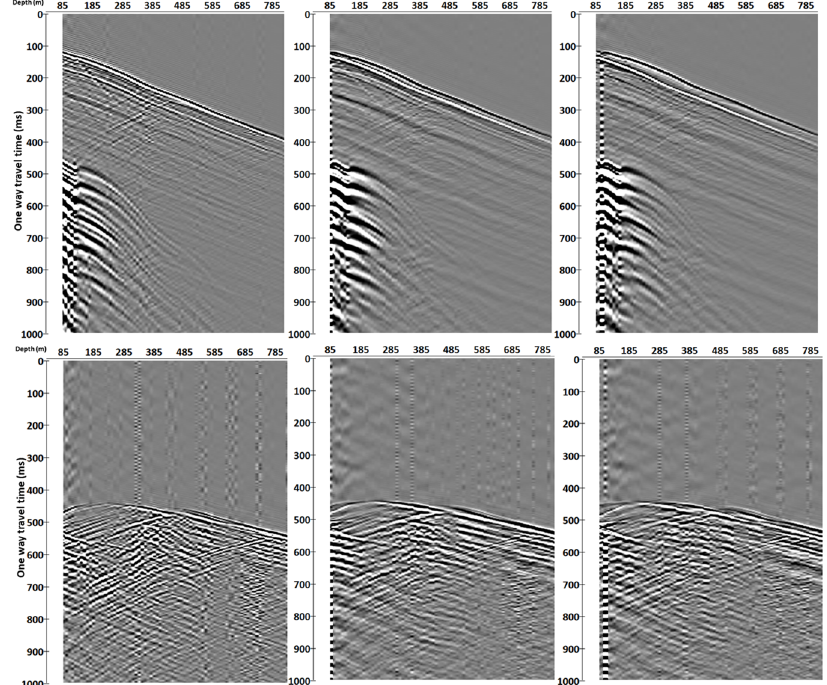
Figure 8. Gauge length simulation of 10 m ( left ), 50 m ( middle ) and 90 m ( right ), for near ( top ) and far ( bottom ) offset converted geophone.